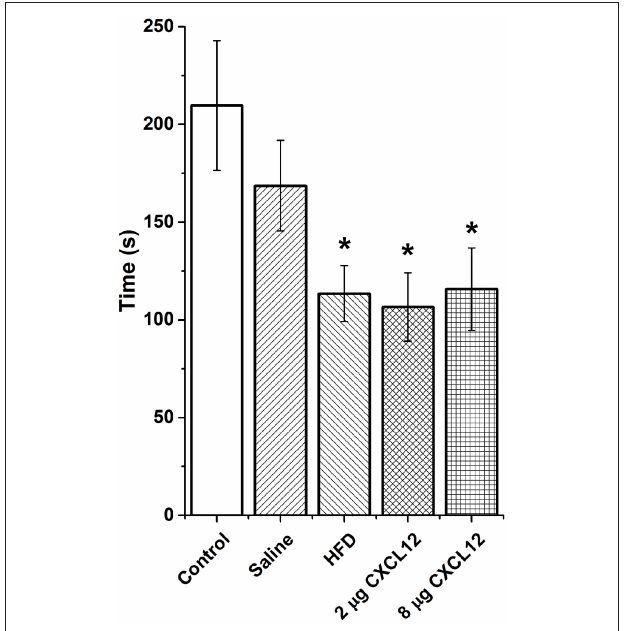
FIGURE 7 | Prenatal HFD and CXCL12 similarly reduce novelty-seeking. Prenatal exposure to a HFD or CXCL12 at 2 or 8 µ g caused a significant decrease in the time spent in the quadrant with a novel object as compared to control offspring. * p < 0.05 vs.